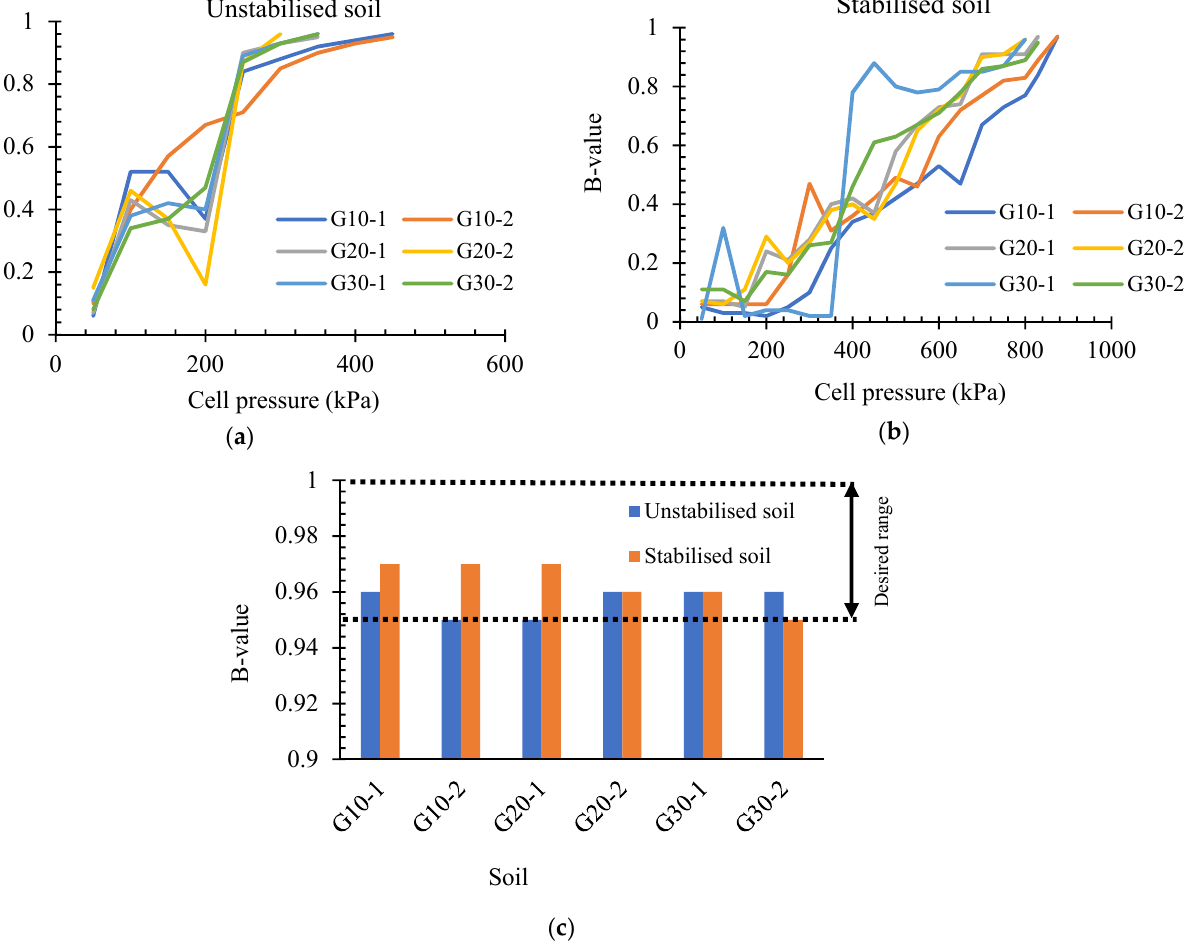
Figure 2. Stepped input pressure: ( a ) unstabilised soil; ( b ) stabilised soil; ( c ) B-value range of unstabilised and stabilised soils.